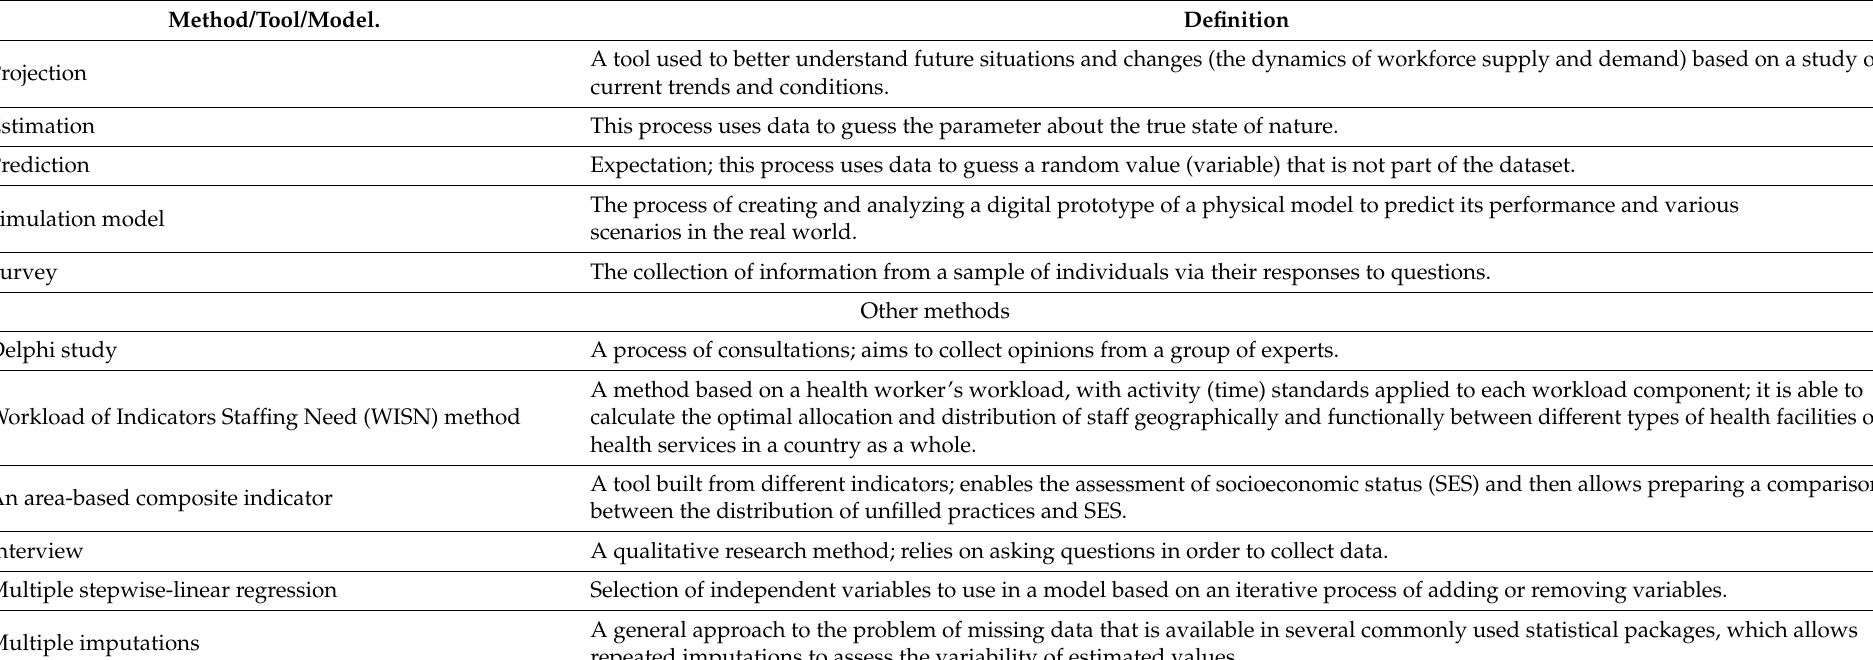
Table 2. Definitions of identified methods, tools, and